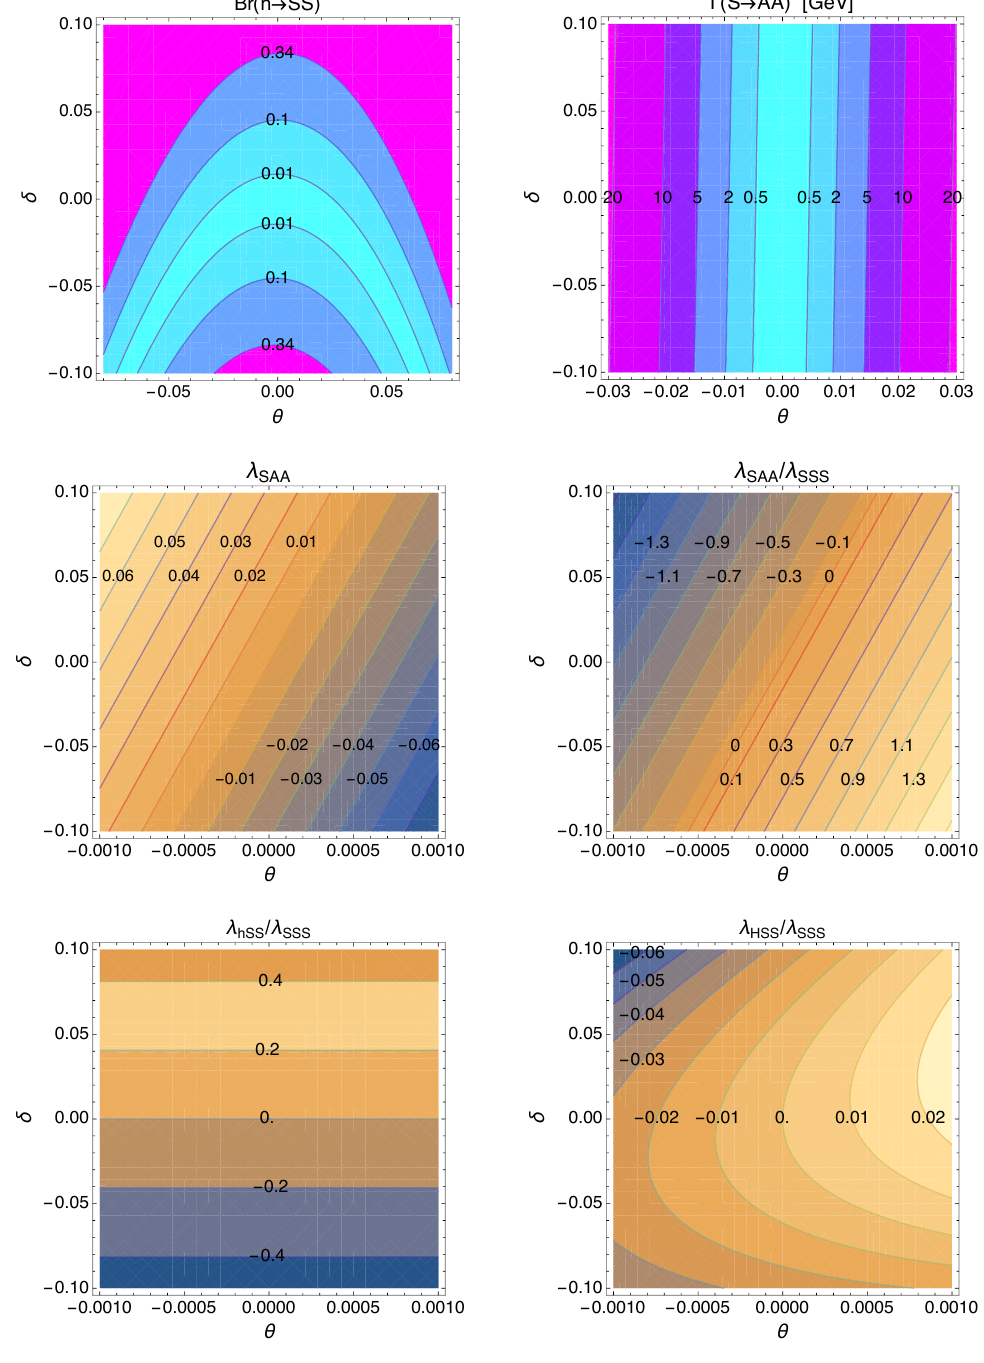
Figure 6 . The contour plots on the ( (cid:18); (cid:14) ) plane for Br( h ! SS ) ; (cid:0)( S ! AA ) ; (cid:21) SAA , (cid:21) SAA =(cid:21) SSS , (cid:21) hSS =(cid:21) SSS , and (cid:21) HSS =(cid:21) SSS , where the parameters given in eq. (5.1) are